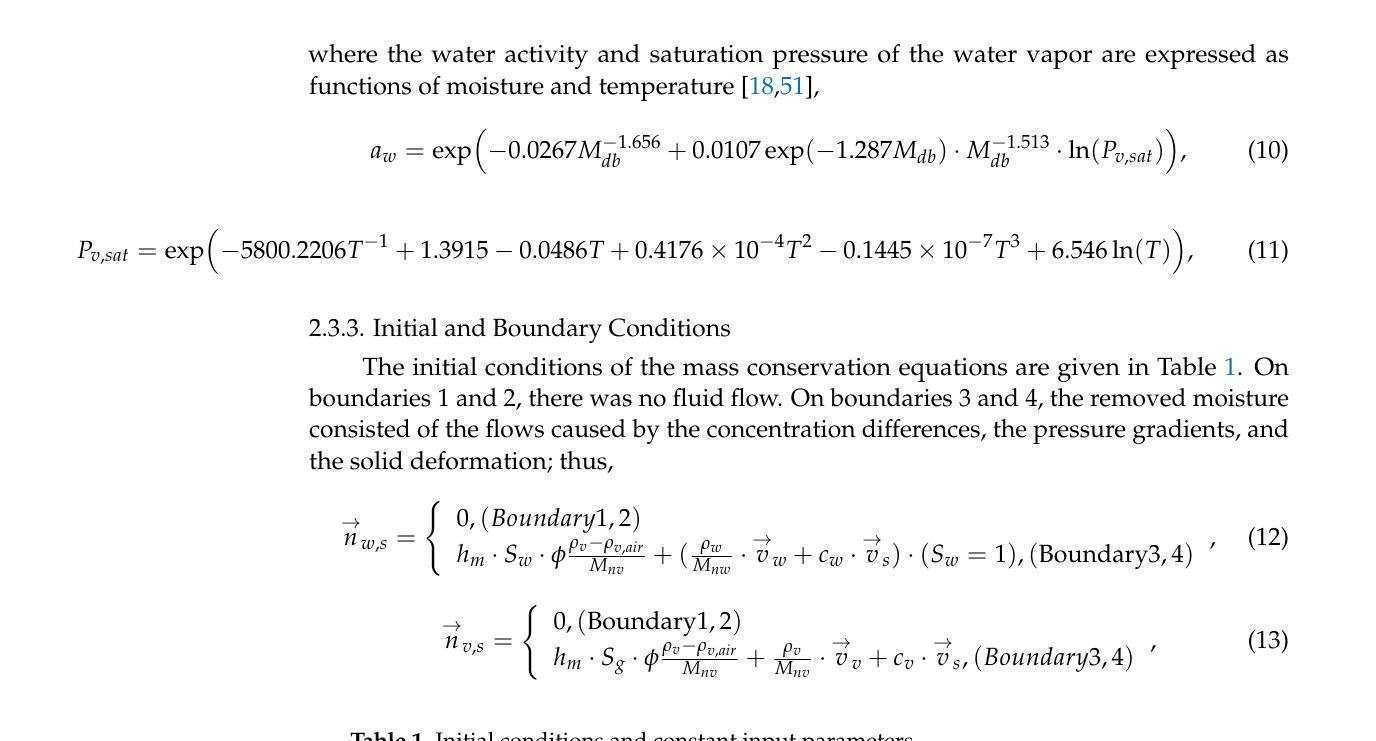
Table 1. Initial conditions and constant input